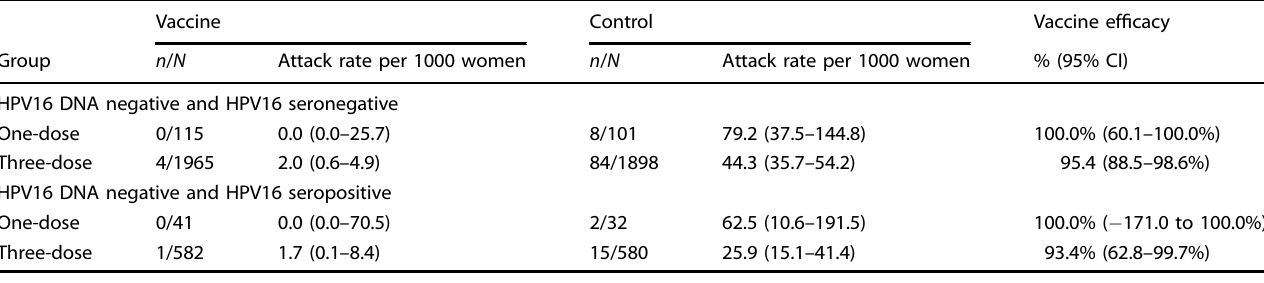
Table 3. Bivalent HPV16 vaccine ef fi cacy against incident, 6-month persistent HPV16 infections among women who were HPV DNA negative through year 2, strati fi ed by HPV16 serological status at time of vaccination and dose.